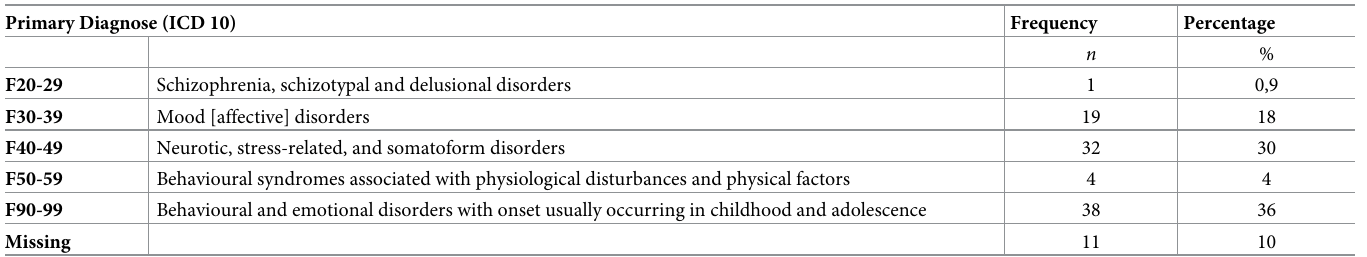
Table 1. Frequency and percentage of primary diagnoses in the clinical sample ( n = 106).